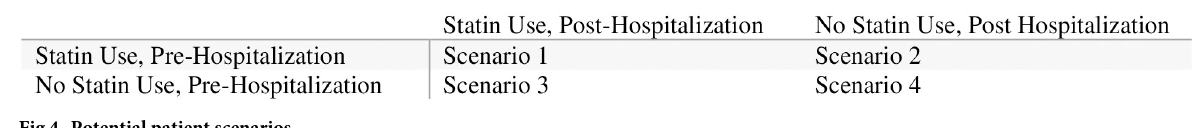
PLOS ONE | https://doi.org/10.1371/journal.pone.0253576 June 24,